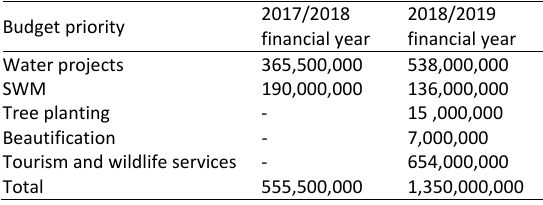
Table 7 . Budgetary allocation (Kshs) for WENR (County Government of Uasin Gishu, 2017; 2018)